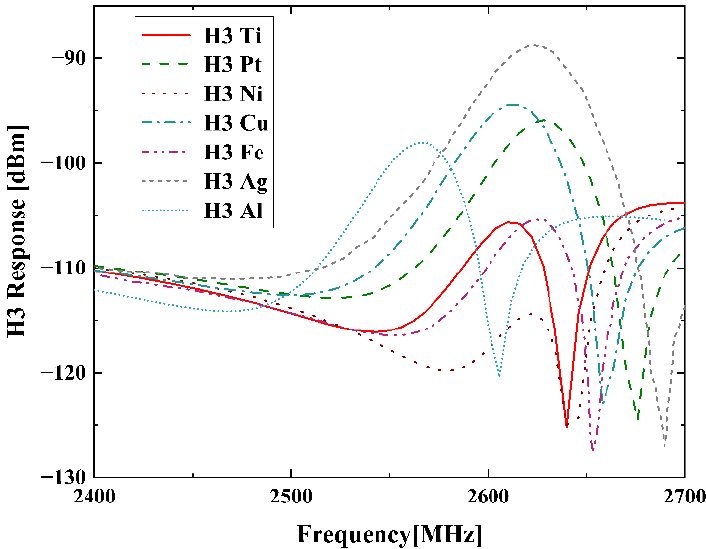
Figure 7. Simulated H3 responses of the SAW resonators with different electrode materials.